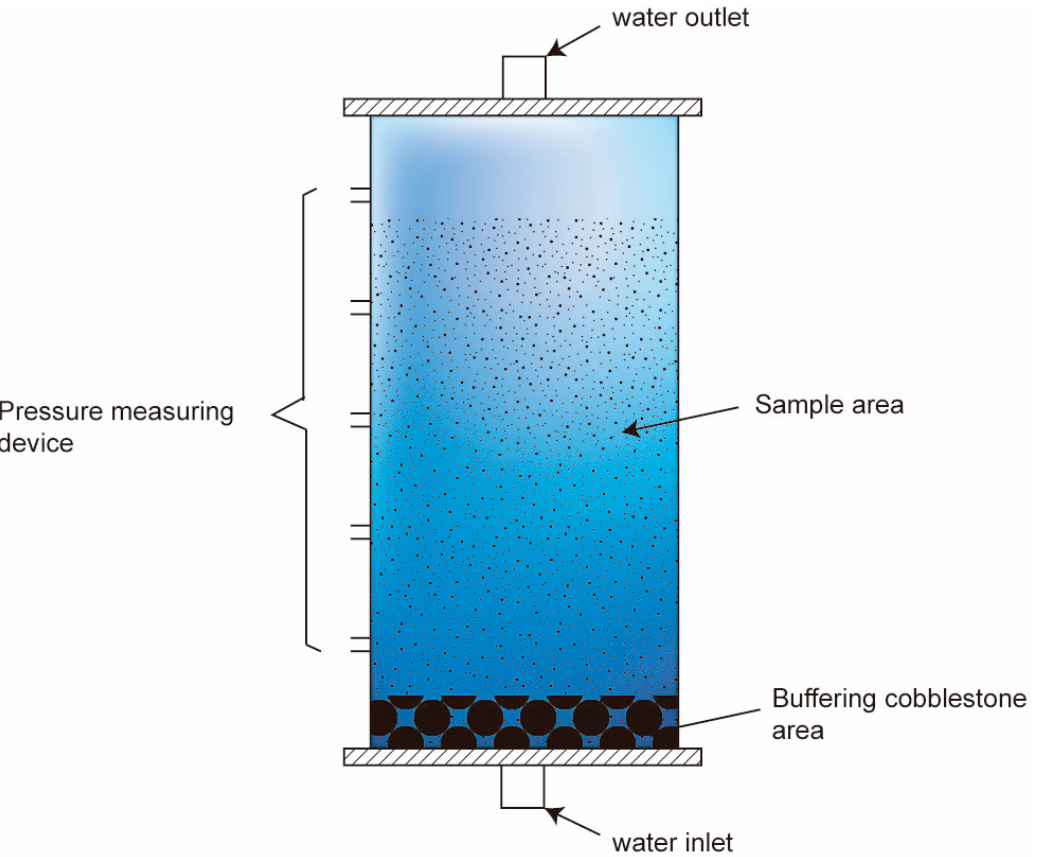
Figure 4. Diagram of the experimental model.